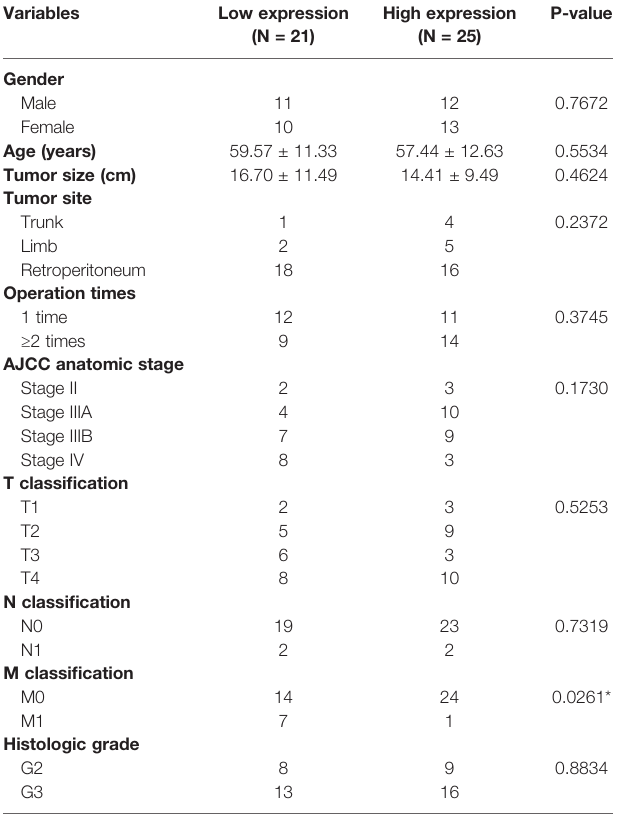
TABLE 4 | Correlation between CCNDBP1 expression and clinicopathological characteristics of patients (N = 46). Variables